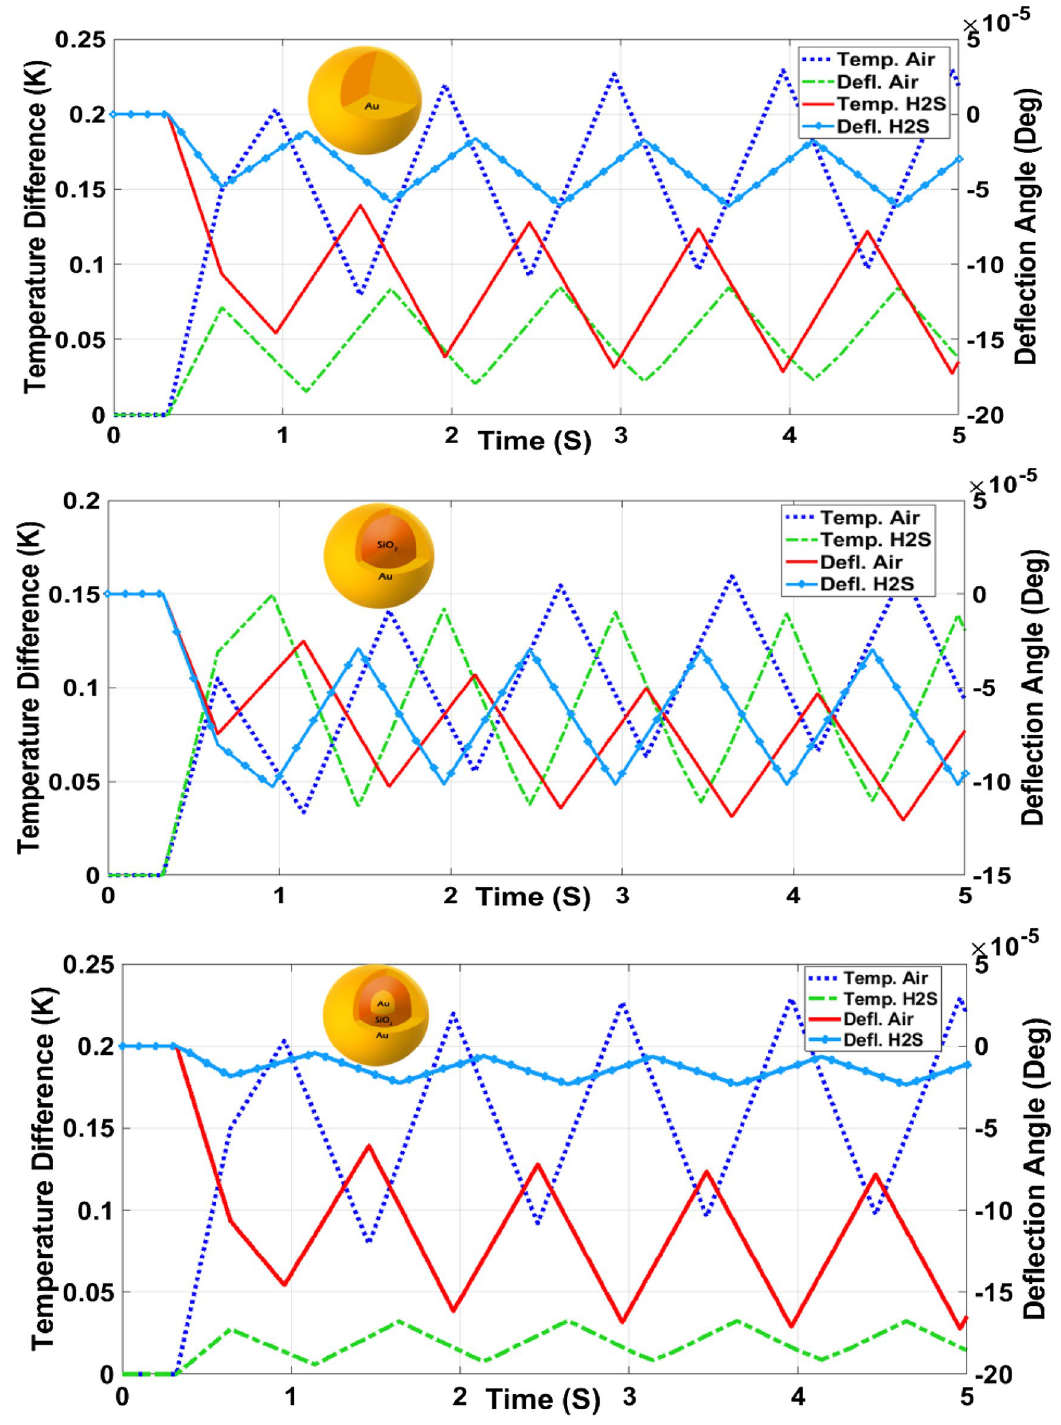
Figure 4. Temperature difference and deflection angle for ( a ) Au nanosphere, ( b ) SiO 2 –Au core–shell, and ( c ) Au–SiO 2 –Au nanomatryoshka in presence of air and H 2 values of the absorbed heat and deflection angle in the same manner. In order to model the functionality of the system, we have used computational modelling approach. First, the effect of gas adsorption on the absorption spectrum of three different Au nanostructures is modeled through solving Maxwell’s equations. The variation of the temperature in the surrounding medium of the sensing element (substrate + Au nanostructures) is calculated by solving the heat transfer equation via the finite element method (FEM) in the COMSOL Multiphysics version 5.3 environment 53 . Deflection of the laser beam resulting from the temperature gradient was calculated according to the governing equation for the propagation of laser beam.